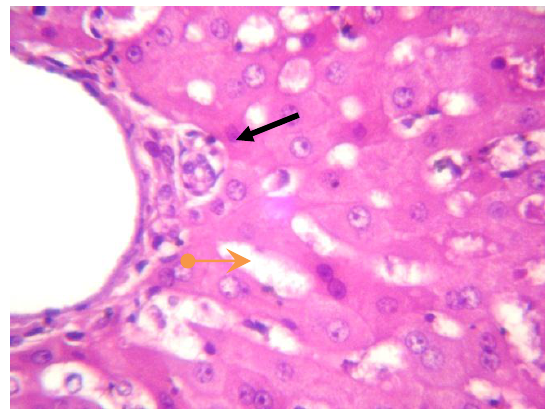
Fig 7: Microscopic section of lung from 1st Immunized group at 20 days post challenge show increase thickening of internal septa with MNCS infiltration (H&E X20).